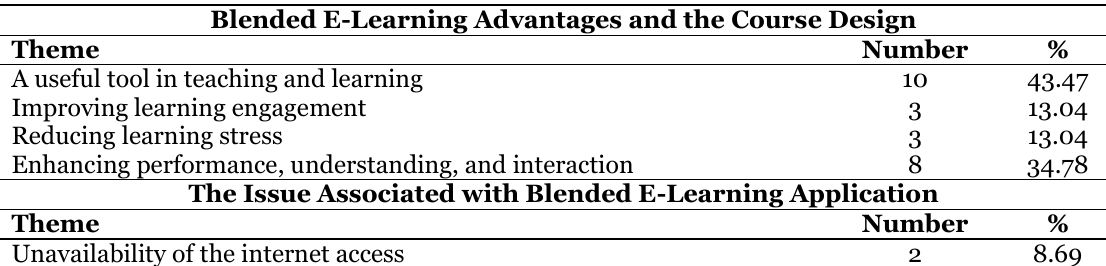
The Generated Themes from the Qualitative Analysis (N=23) Blended E-Learning Advantages and the Course Design Theme A useful tool in teaching and